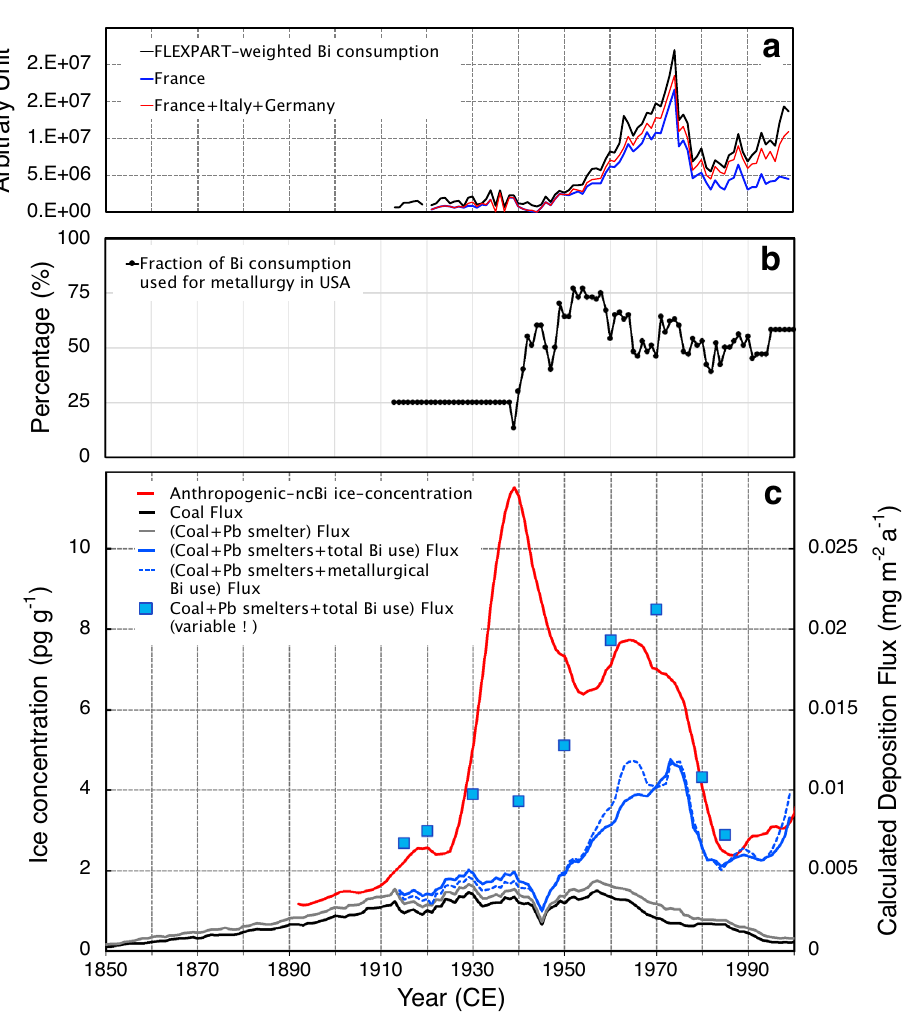
Figure 3. Contribution of coal burning and various metallurgical processes leading to Bi pollution as recorded in CDD ice. ( a ) Bismuth consumption scaled by FLEXPART emission sensitivities of European countries contributing to deposition at CDD. ( b ) Fraction of Bi consumption used for metallurgy in the United States. ( c ) Summer ice-core trends of non-crustal Bi from which the pre-industrial value (0.27 pg g −1 ) was subtracted (red line), and deposition fluxes at CDD calculated by FLEXPART using estimated past anthropogenic emissions from coal burning (black line), coal burning plus Pb smelter (grey line) and coal burning plus Pb smelter and Bi use (blue solid line). The blue squares refer to deposition fluxes calculated by assuming changes over time of the amount of Bi emitted per tonne of Bi consumed (α values, see “Methods”) to account for emission reductions following technological improvements. The dashed blue line refers to emission scenario that considers only Bi use in